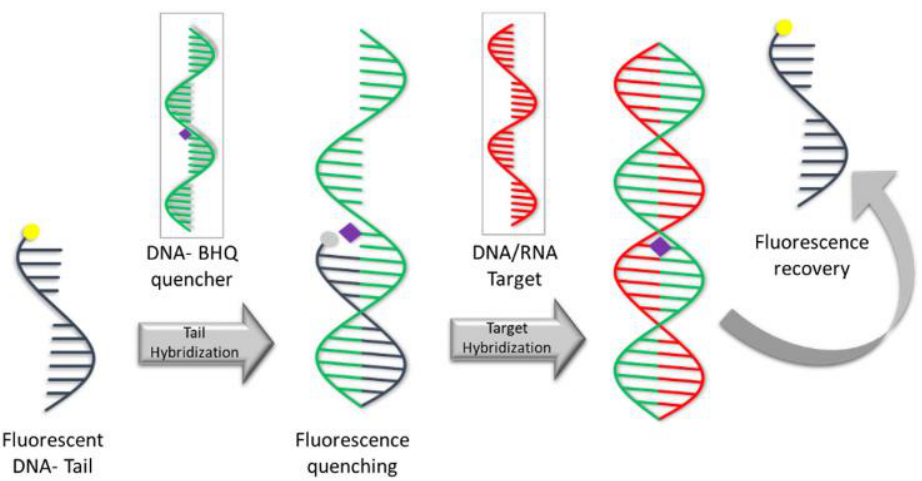
Figure 12. The mechanism of DNA-PEG hydrogels detection assay [165].